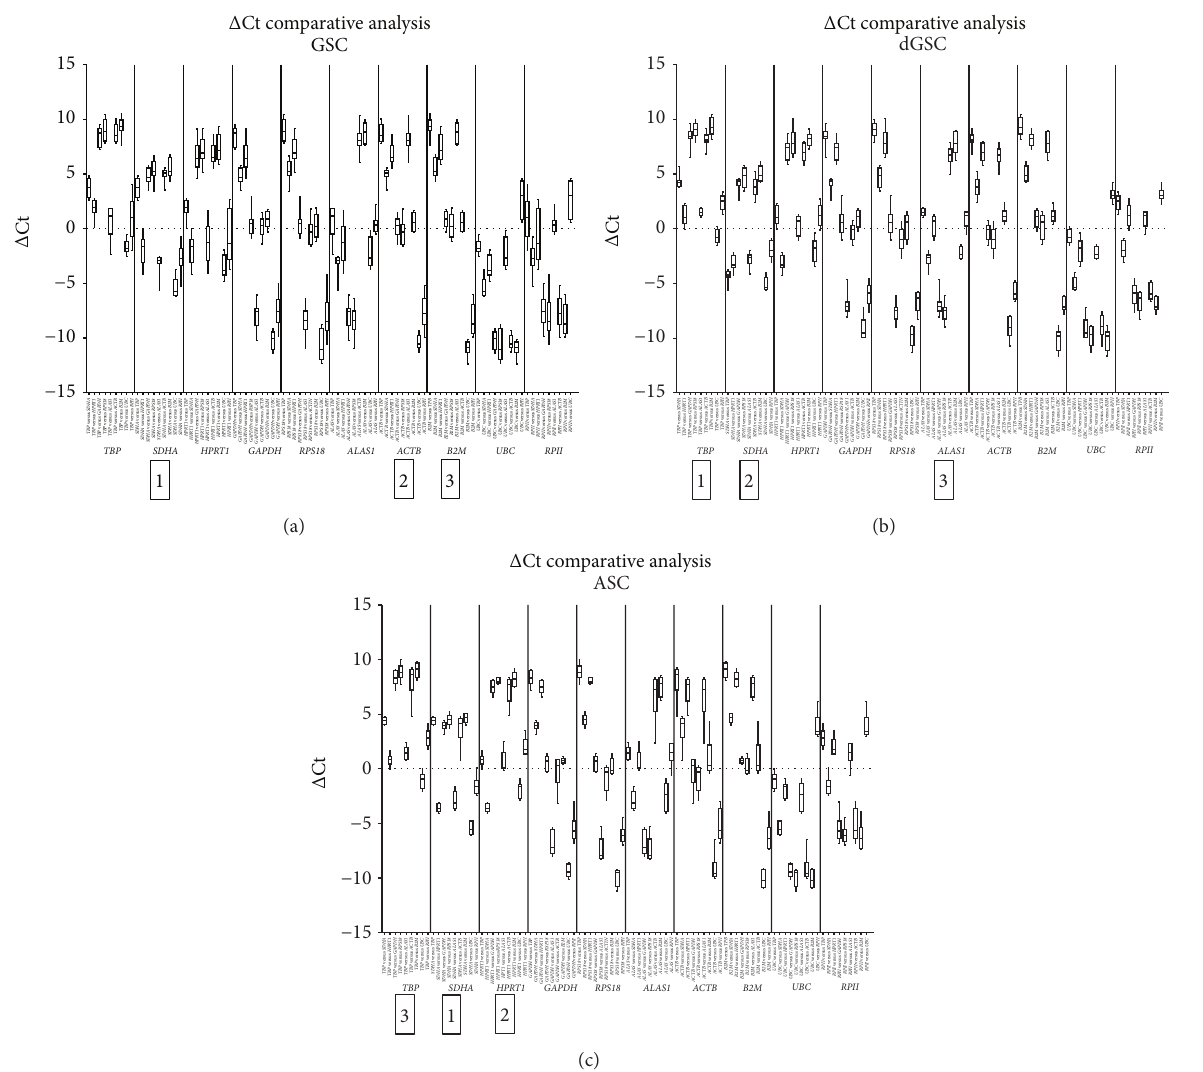
Figure 3: Ranking of 10HKG in GSC (a), dGSC (b), and ASC (c) with Δ Ct comparative method. Δ Ct variability with pairwise comparisons of the complete set of candidate housekeeping genes shown as boxes and whiskers: medians (lines), 25th and 75th percentiles (Boxes). Genes with lowest variability were the most